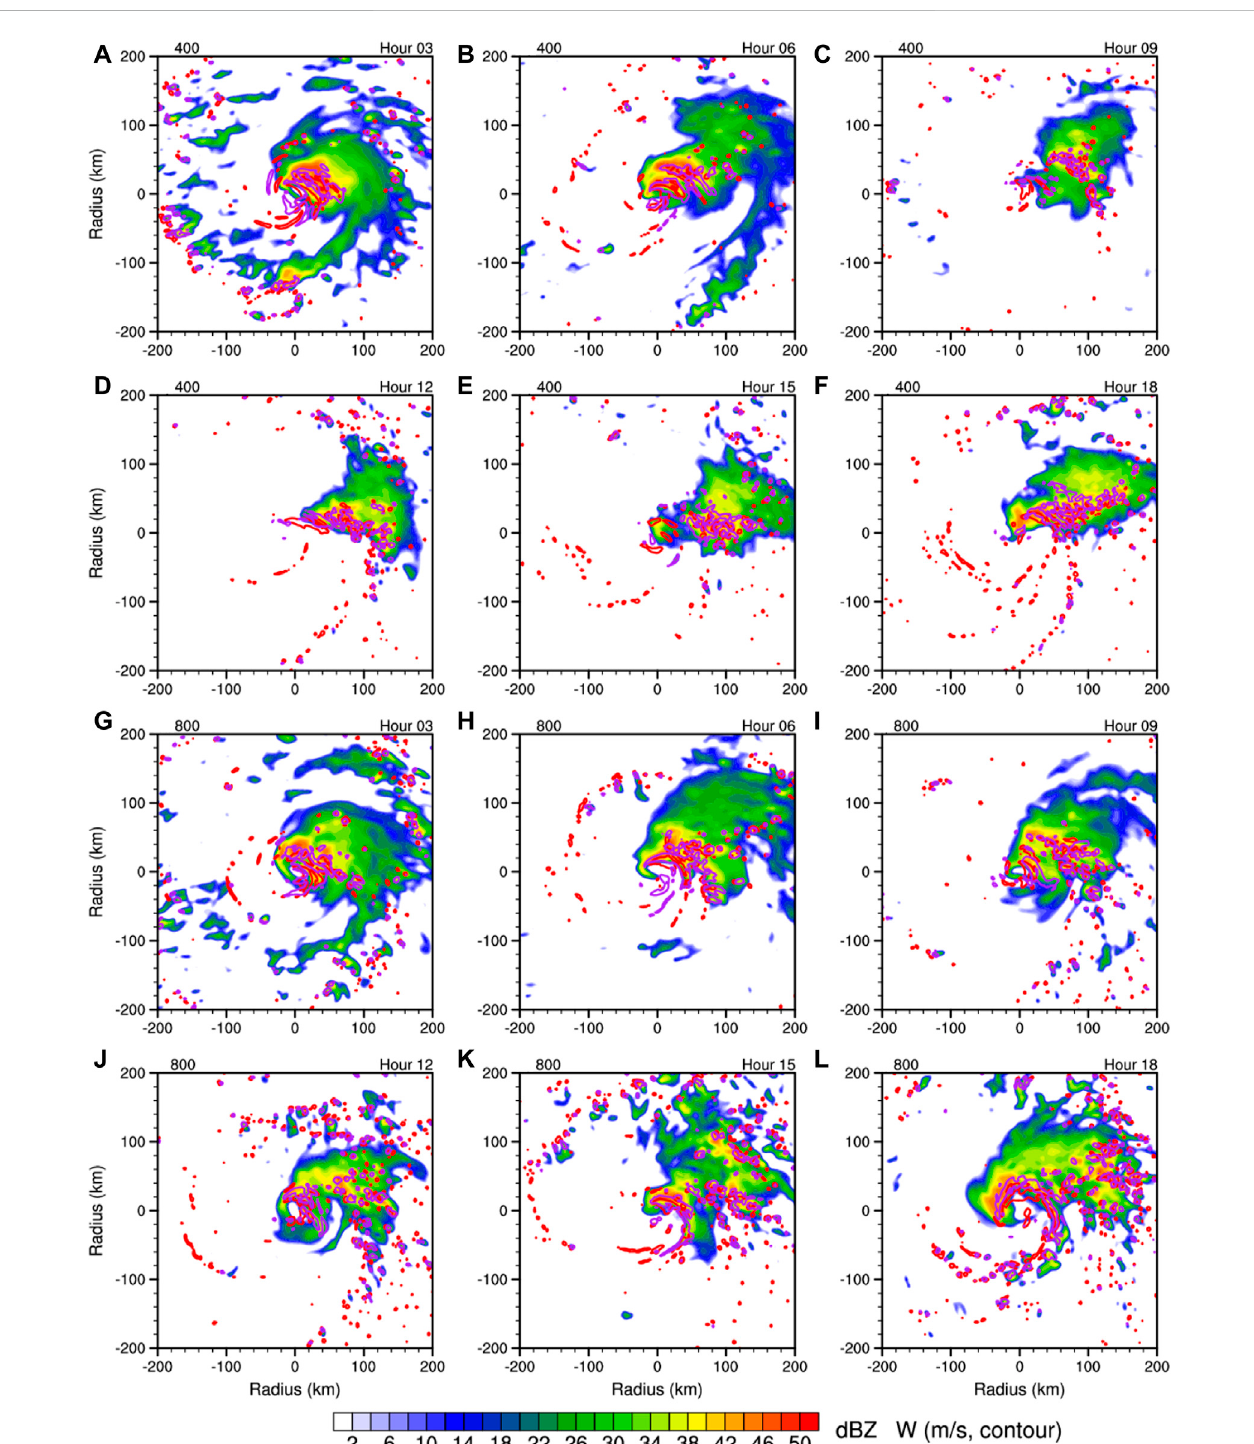
Evolution of the radar re fl ectivity (shaded, dBZ) at 1.5 km and vertical velocity (contour at 0.5 m s − 1 ) at 1.5 (red) and 5 (purple) km in the fi rst 18 h. (A – F) Data from EXP400. (G – L) Data from EXP800.